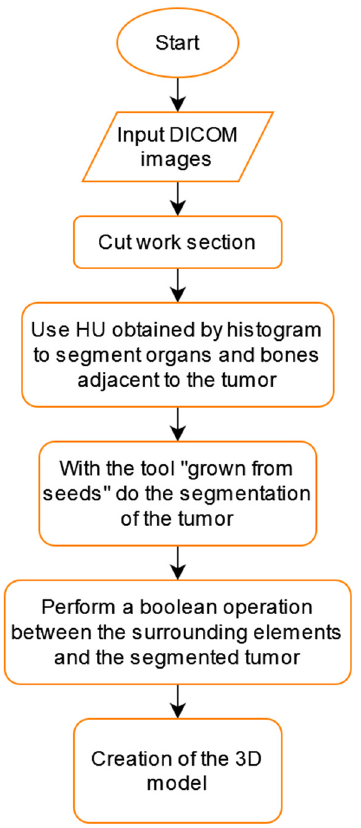
Figure 10. Tumor segmentation flowchart using 3D Slicer.